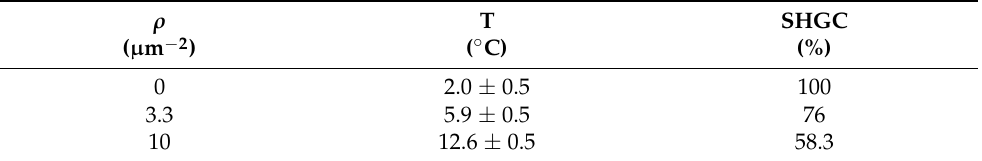
Table 1. Measured temperature and solar-heat-gain coefficient (SHGC) measured on the underside of the glass slide under full-solar-spectrum illumination for all